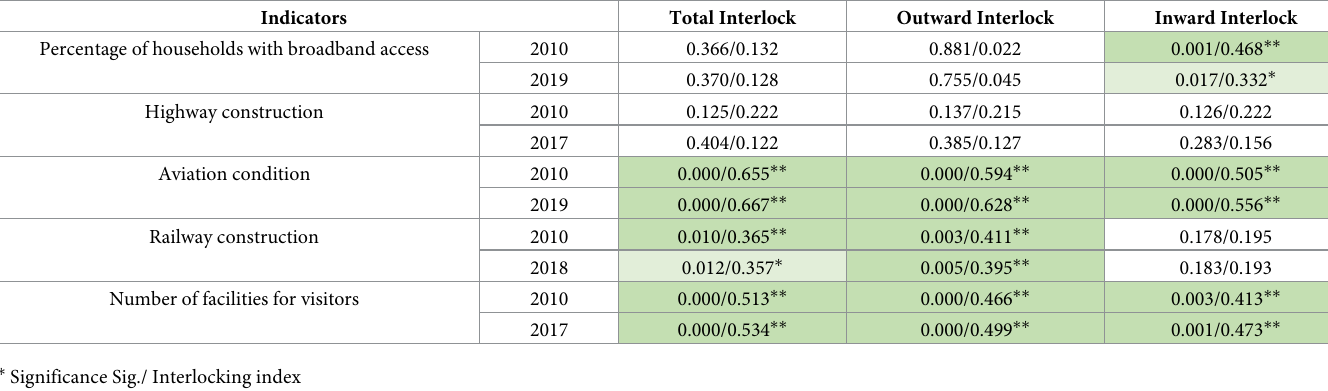
Table 7. The relationship between infrastructure indicators and three interlock types.